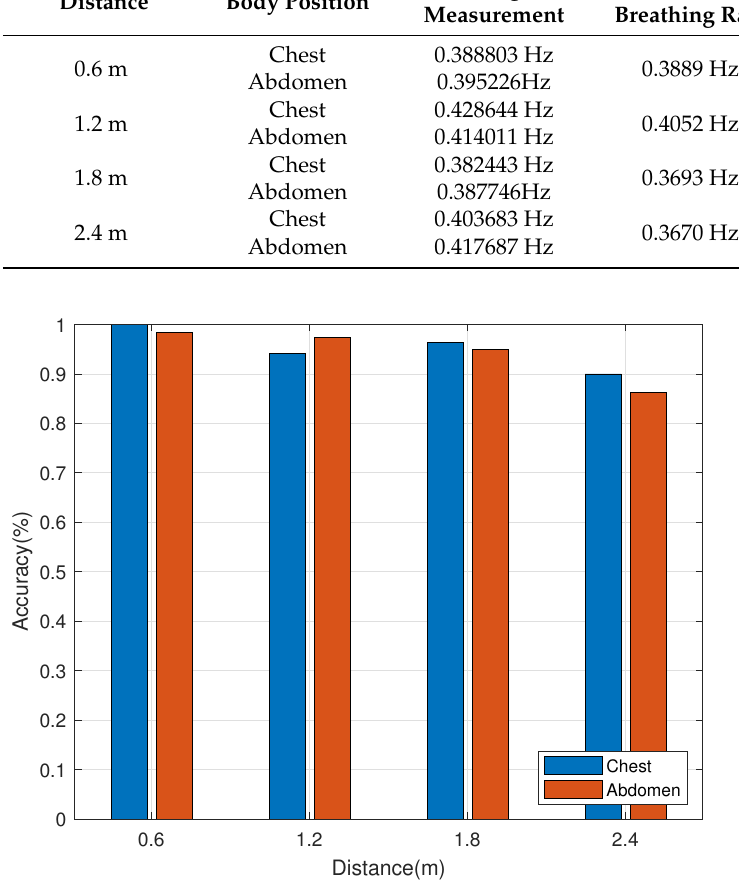
Figure 16. Results of respiratory rate statistics at different